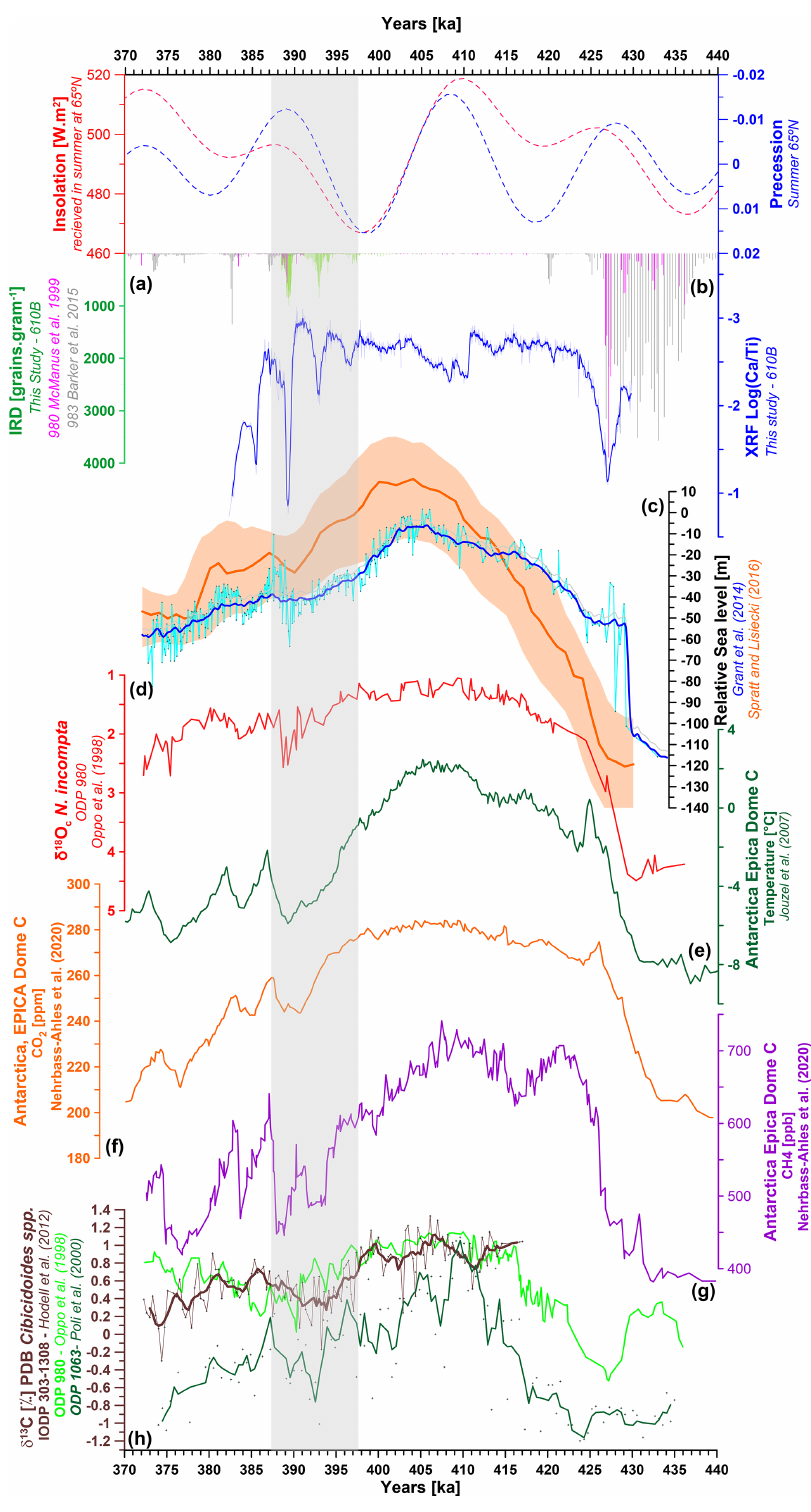
Figure 5. Age model development for DSDP 610B (370–430ka): (a) IRD per gram records from DSDP 610B (green), ODP site 980 (pink), and ODP 983 (black); (b) log(Ca / Ti) record for DSDP 610B (blue); (c) global relative sea level curve (blue and orange); (d) ODP 980 δ 18 O N. incompta (red); (e) EDC Antarctic ice core temperature (green), (f) carbon dioxide (CO 2 , orange), and (g) methane records (CH 4 , purple); and (h) benthic δ 13 C record from ODP 980, IODP 303-U1308, and ODP 1063 (brown, light green, and green, respectively). The grey band indicates the interval of this